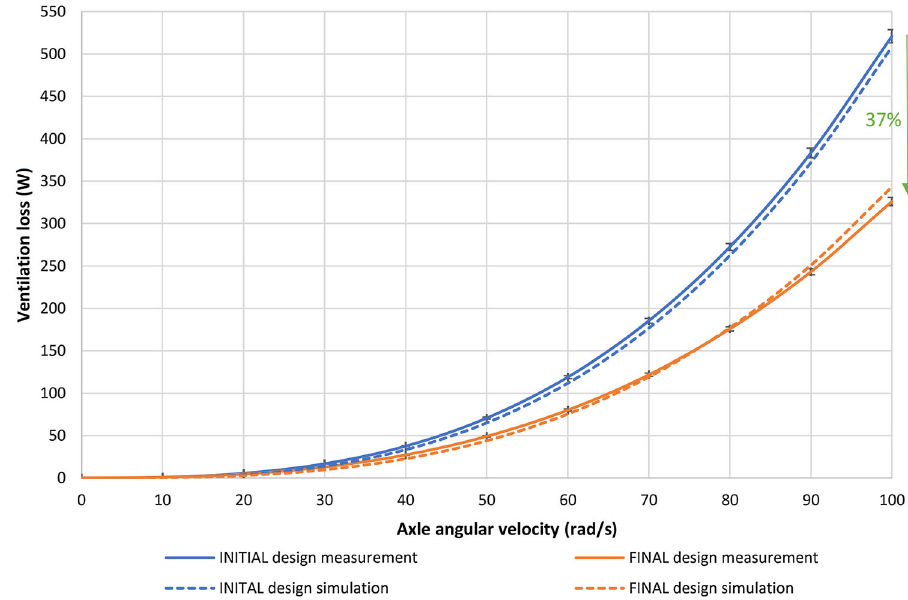
Fig. 10 Comparison of measured and simulated ventilation losses